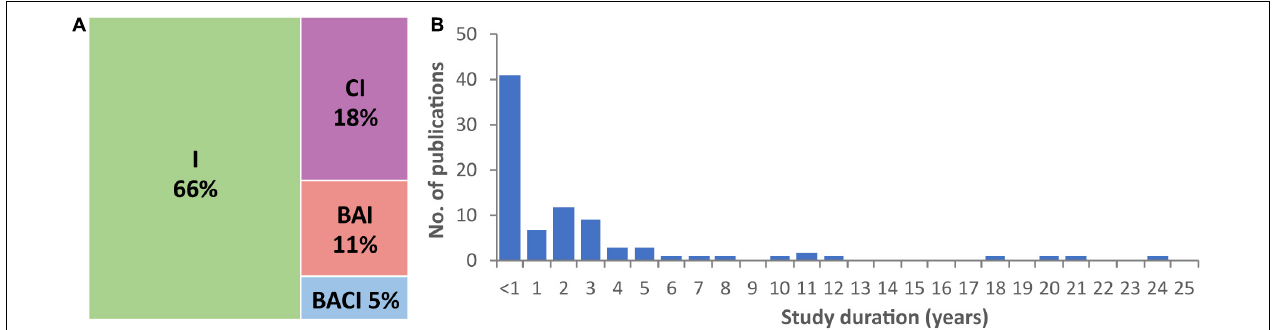
FIGURE 2 | (A) Frequency (%) of exclusion barrier studies reviewed by experimental design. I, impact only; CI, control impact; BAI, before after impact; BACI, before after control impact. (B) Duration of exclusion barrier studies.